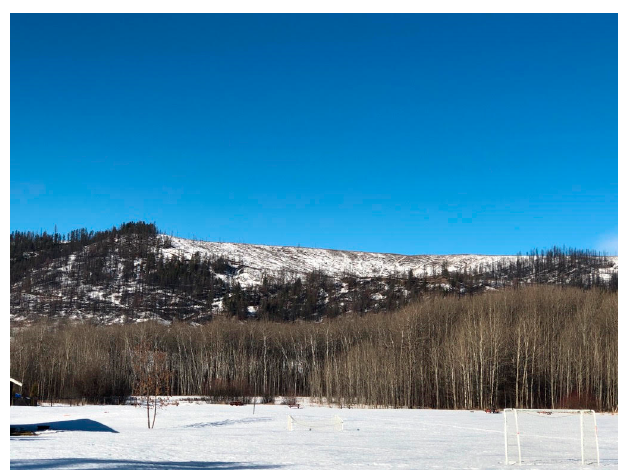
Figure 3. Burnt mountain in Sugarcane reserve, with regrowth.